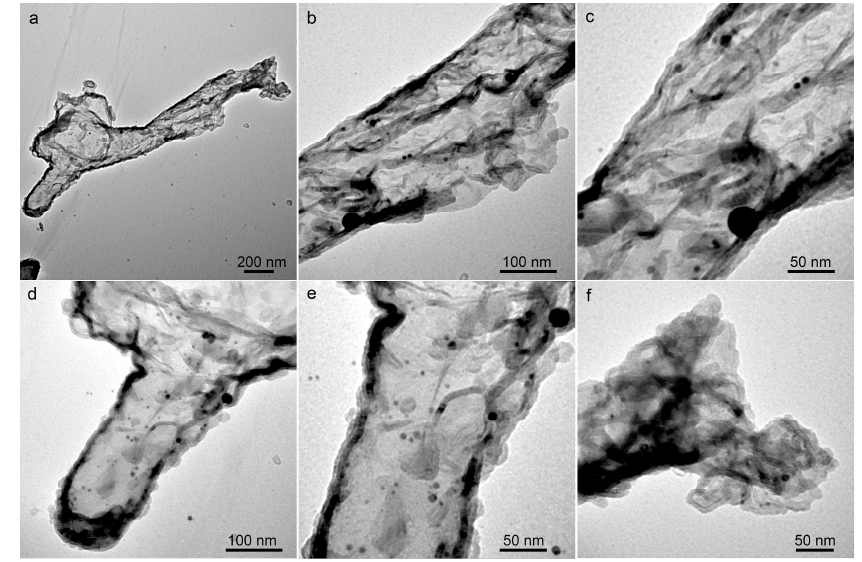
Figure 9. ( a – f ) TEM images of the carbon nanosheet formed during storage of the colloids.